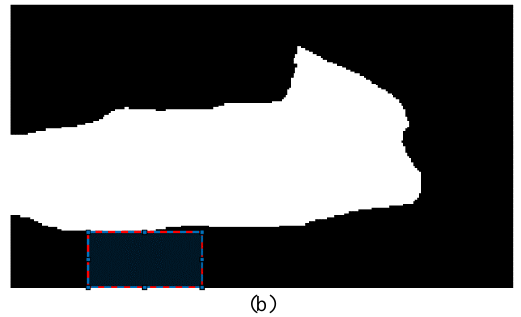
Figure 2 . The ROI of the study area. (a) ROI overlaid with the original image. (b) ROI overlaid with the binary image. When in normal condition, the whole ROI is filled with black pixels (no water).